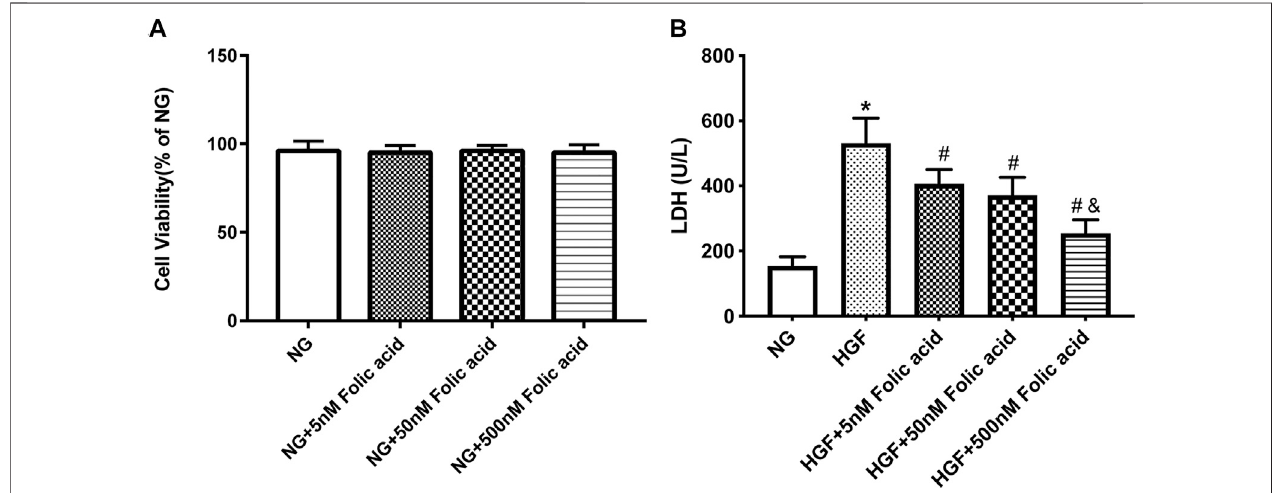
FIGURE 1 | Effect of folic acid on cell viability in H9C2 cells. (A) Cell viabilities of folic acid on H9C2 cells. (B) The protective effects of 0 – 500 nM folic acid on the viability of H9C2 cells treated with HGF. * p < 0.05, compared with NG; # p < 0.05, compared with HGF; & p < 0.05, compared with HGF+50 nM folic